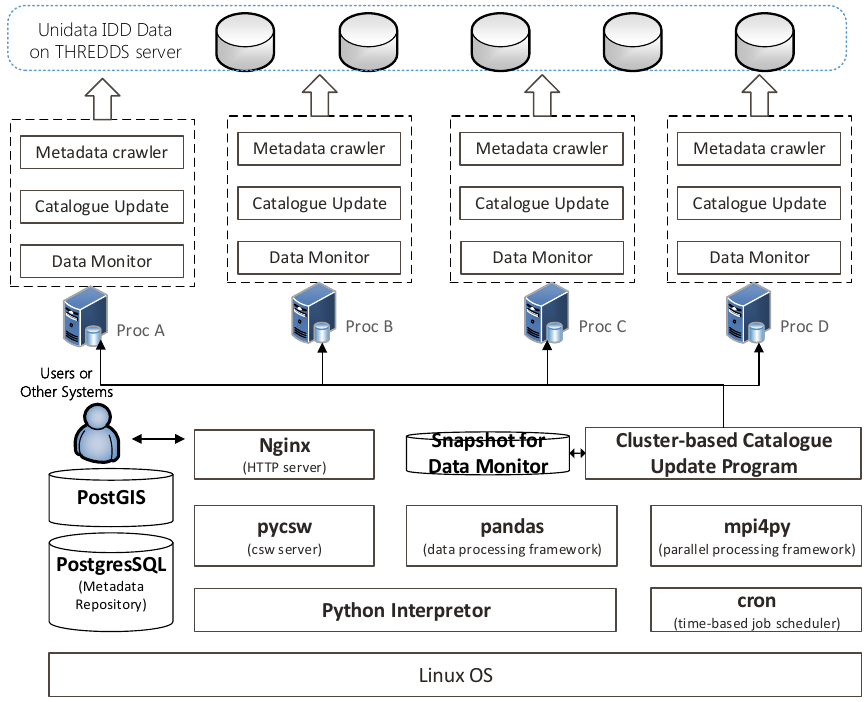
Figure 7. Framework of the near-real-time OGC CSW service for Unidata IDD data.